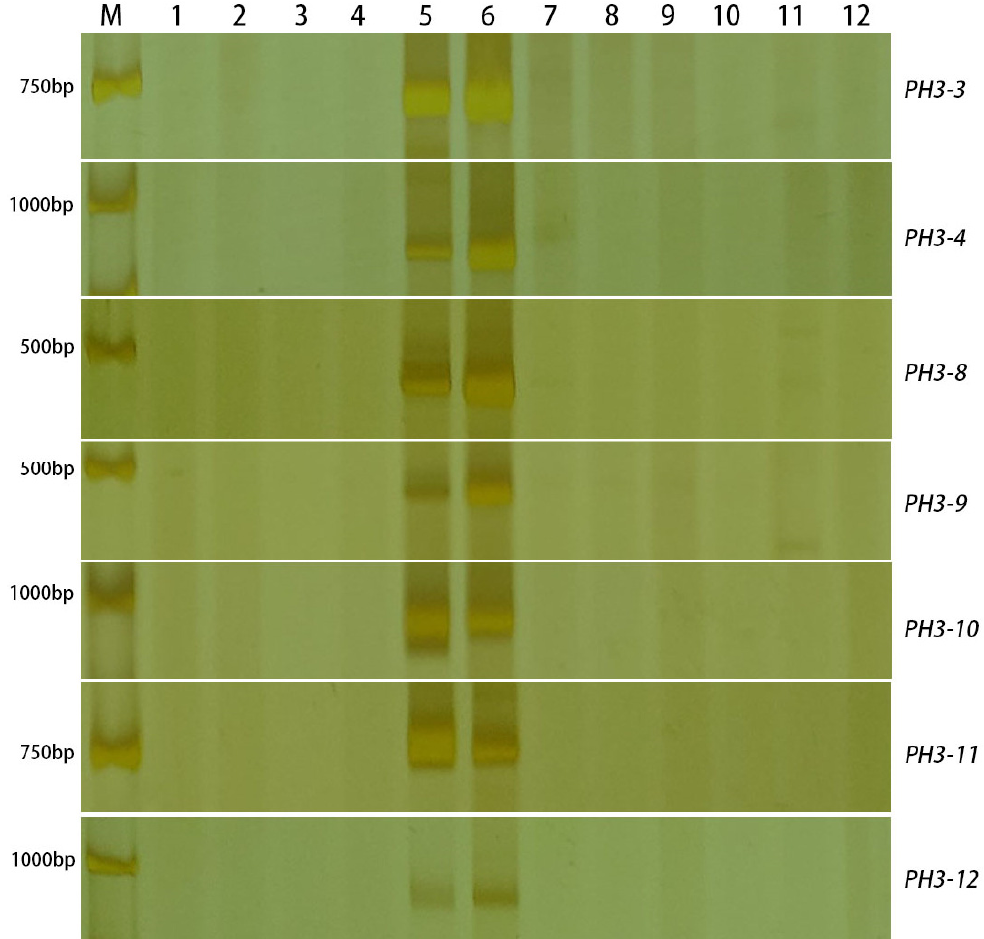
Figure 6. The amplification of the developed markers designed by RNA-seq DEGs. There are specific bands only on P. huashanica and 20JH1155 among common wheat and wheat-related species. M: D2000. 1: 7182. 2: CS. 3: AK58. 4: Trs-372. 5: P. huashanica . 6: 20JH1155. 7: S. cerale . 8: Ae. geniculata.